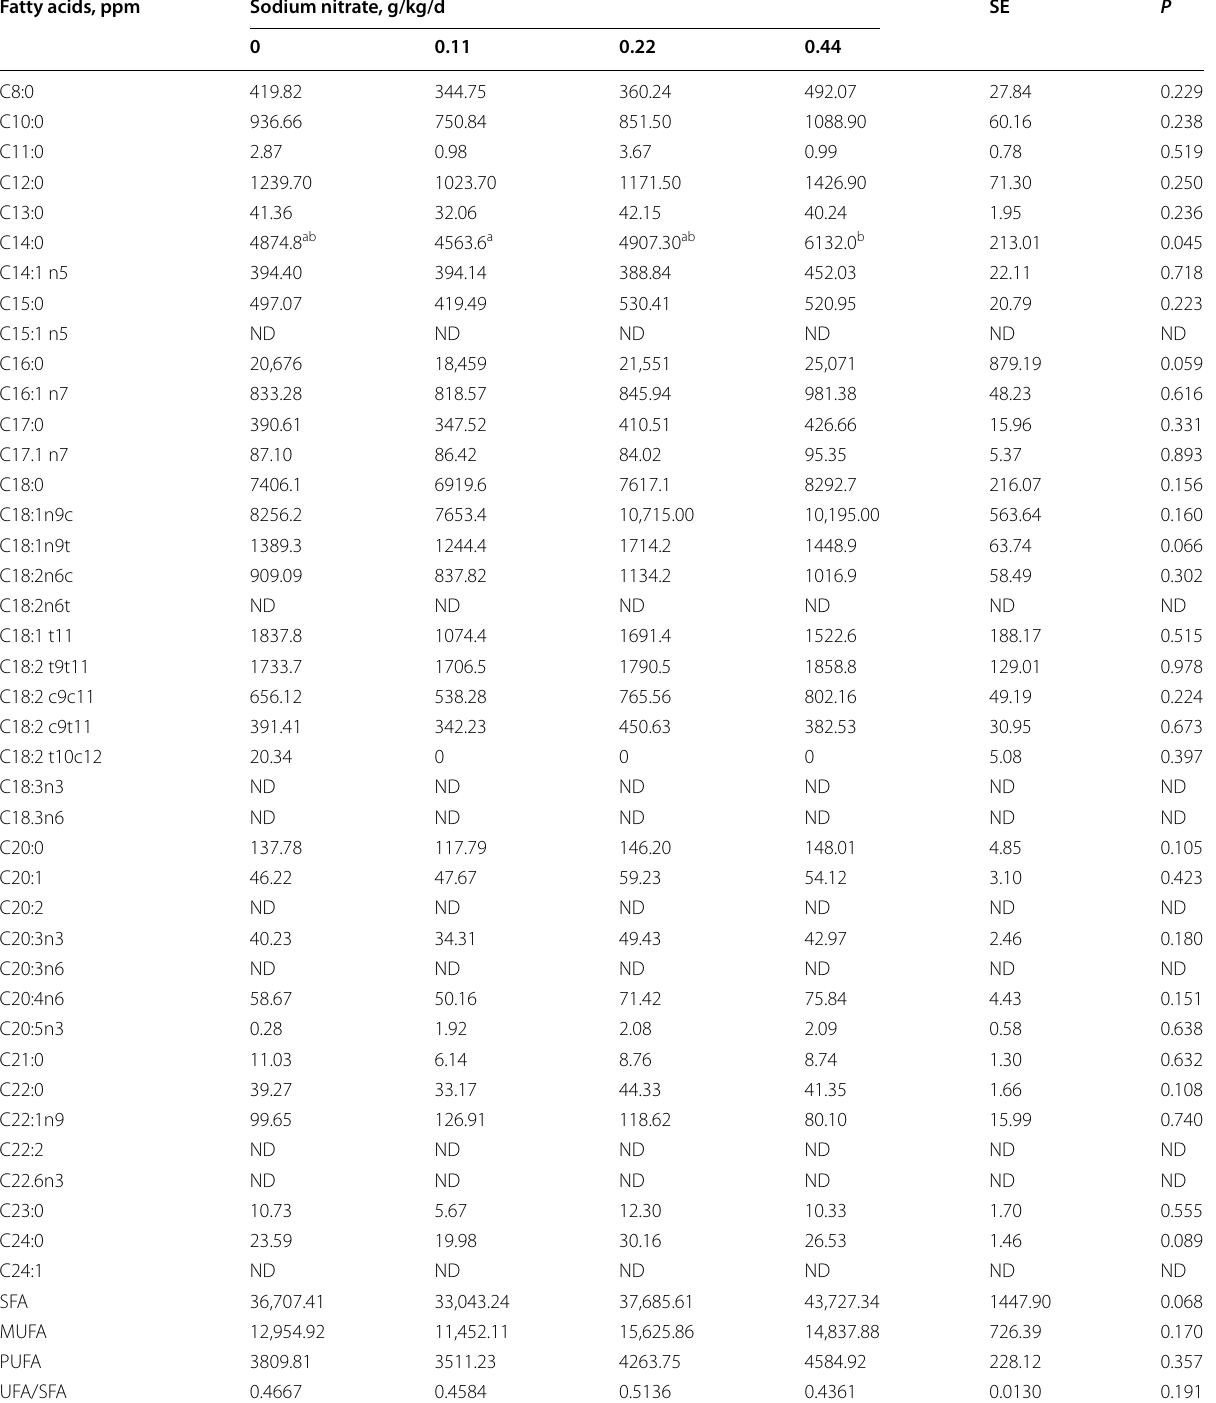
Different letters in the same row means significant differences ( P <